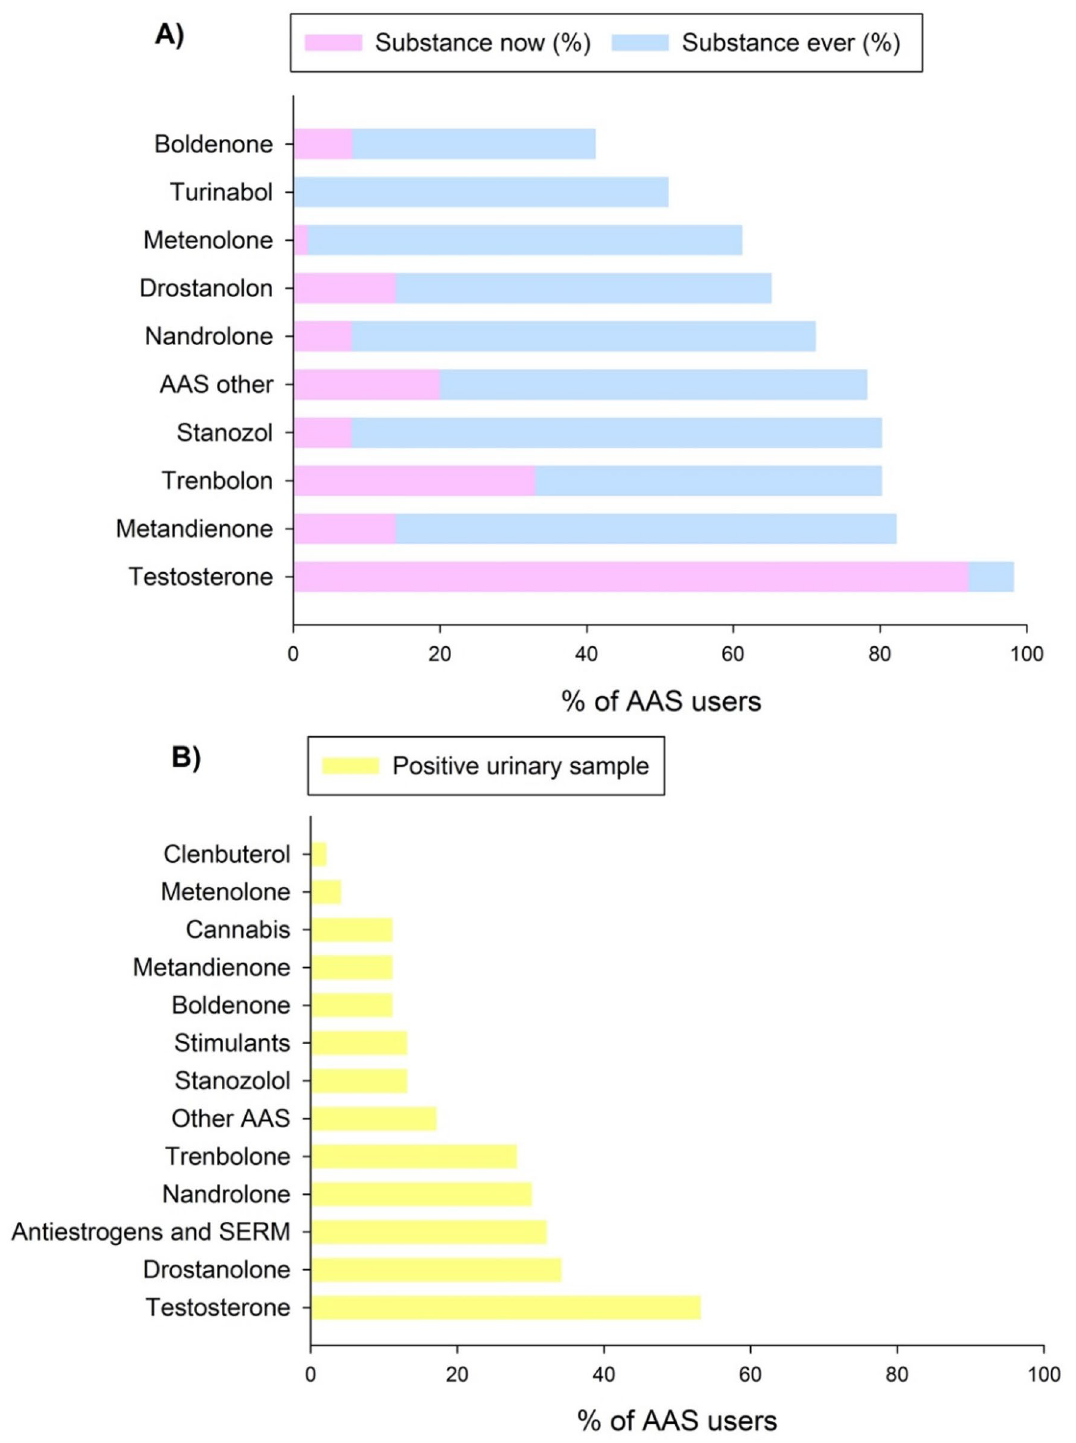
Figure 3. Substance use: ( A ) Substances reported by the anabolic–androgenic steroid (AAS) users (N = 50). Substance preferred is the substance used now. Substance ever is all substances ever used. ( B ) Substances the AAS users (N = 50) tested positive for in the urine